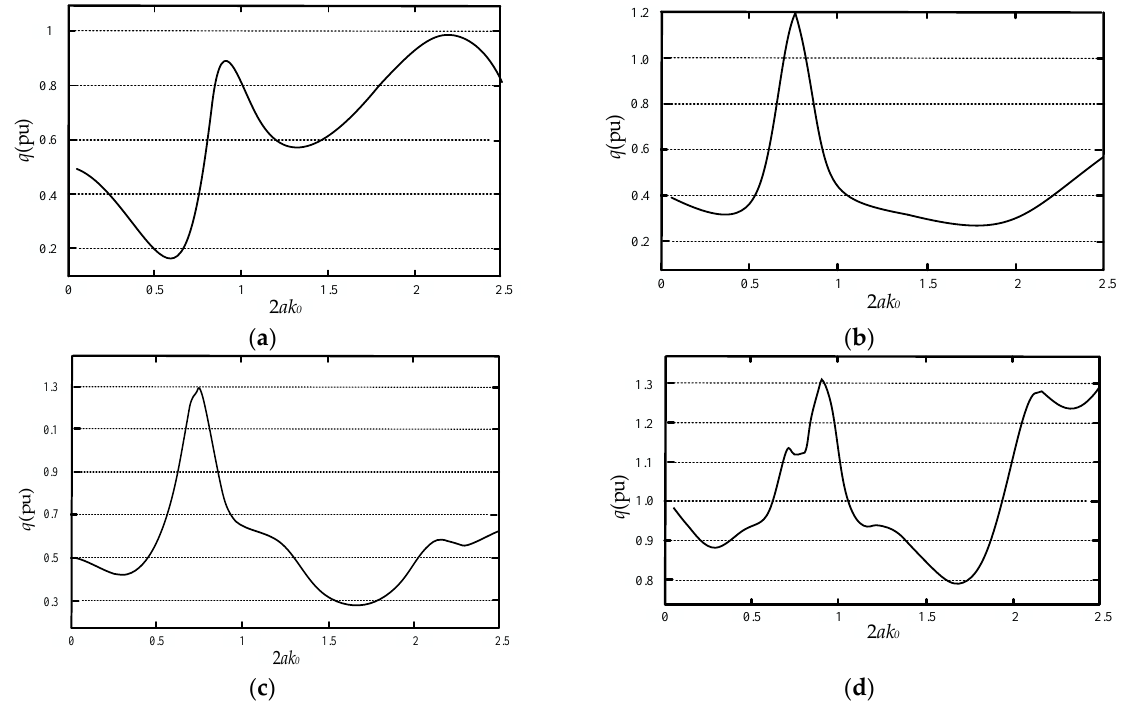
Figure 4. The relationship between q and k 0 : ( a ) N = 2, L = 4 a ; ( b ) N = 2, L = 8 a ; ( c ) N = 3, L = 8 a ; ( d ) N = 4, L = 8 a .